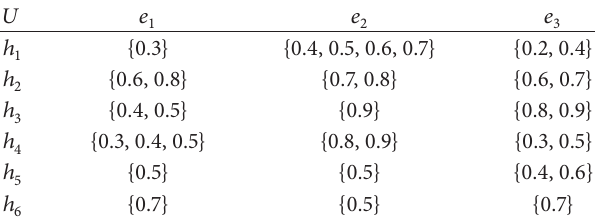
Table 6: The Union of hesitant fuzzy soft sets